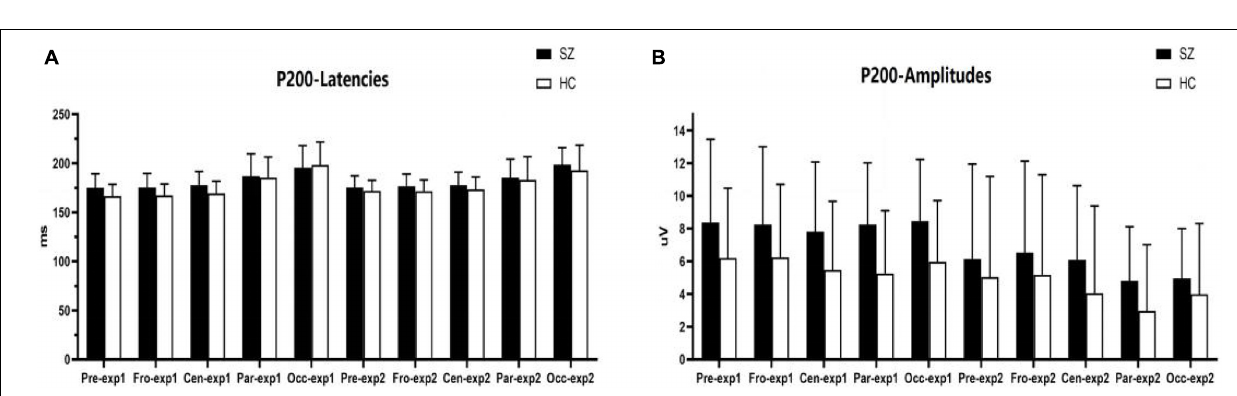
FIGURE 4 | Comparisons of P200 latencies (A) and amplitudes (B) between the schizophrenia group and HC group within sites and experiments. SZ, schizophrenia; HC, healthy control; exp, experiment; Pre, prefrontal, Fro, frontal, Cen, central, Par, parietal, Occ, occipital.